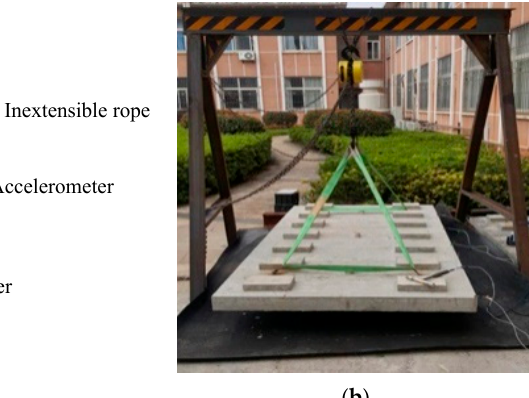
Figure 5. ( a ) Reinforcing bar diagram; ( b ) Newly designed slab track plate; ( c ) Normal slab track plate (mm).